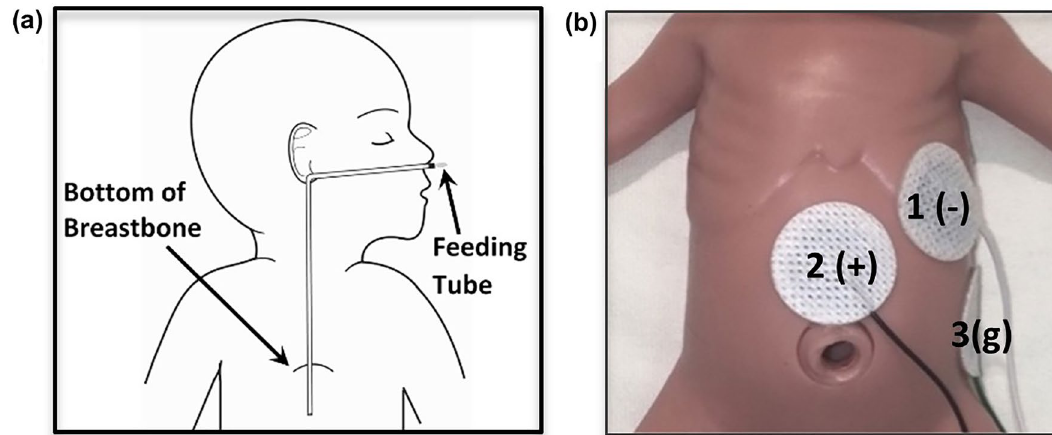
Figure 1. EGG Setup. ( a ) This cartoon shows a standard enteral feeding tube setup utilized in neonatal intensive care units. ( b ) Setup of three EGG electrodes. The negative electrode (marked by ‘1 (−)’) is placed on the left upper quadrant, near the mid-clavicular line. The positive electrode (marked by ‘2 (+)’) is placed midway between the bottom of breastbone and the belly button, slightly below the level of the negative electrode. The ground electrode (marked by ‘3(g)’) is placed at the mid-axillary line, below the left costal